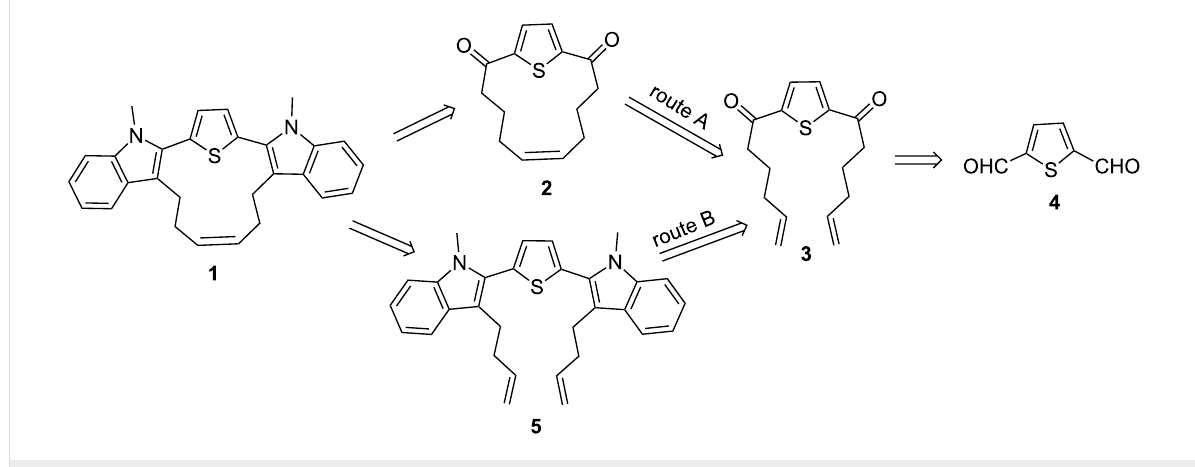
Figure 1: Retrosynthetic approach to hybrid cyclophane derivative 1 .